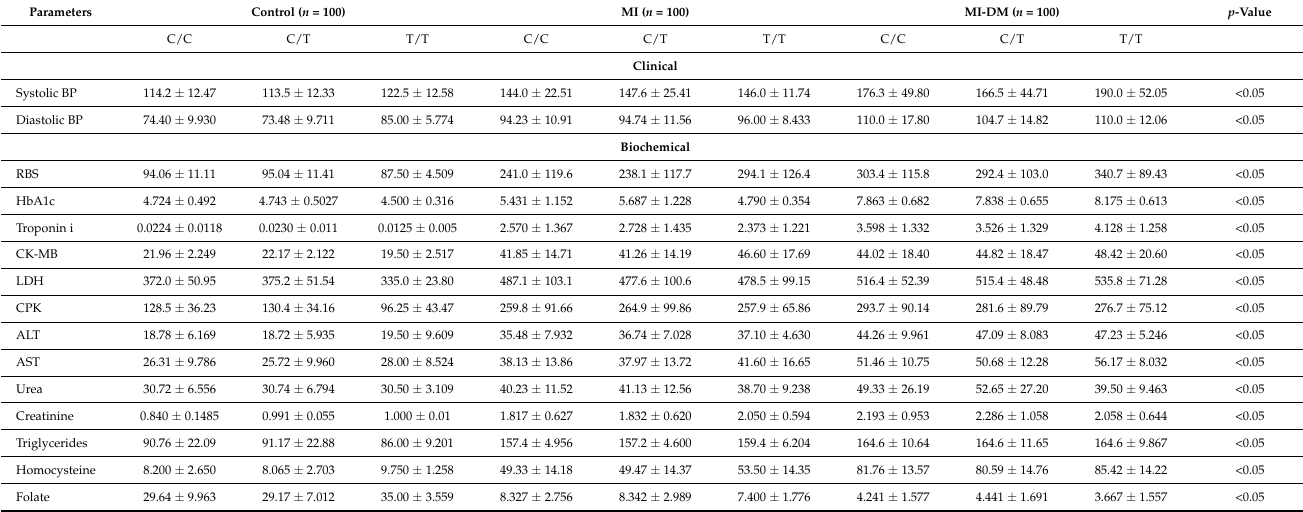
Table 9. Clinical and biochemical parameters for control, myocardial infarction (MI), and myocardial infarction with diabetes mellitus (MI-DM) according to genotype (C/C, C/T, and T/T) of MTHFR C677T (rs1801133). The data are presented as means ±